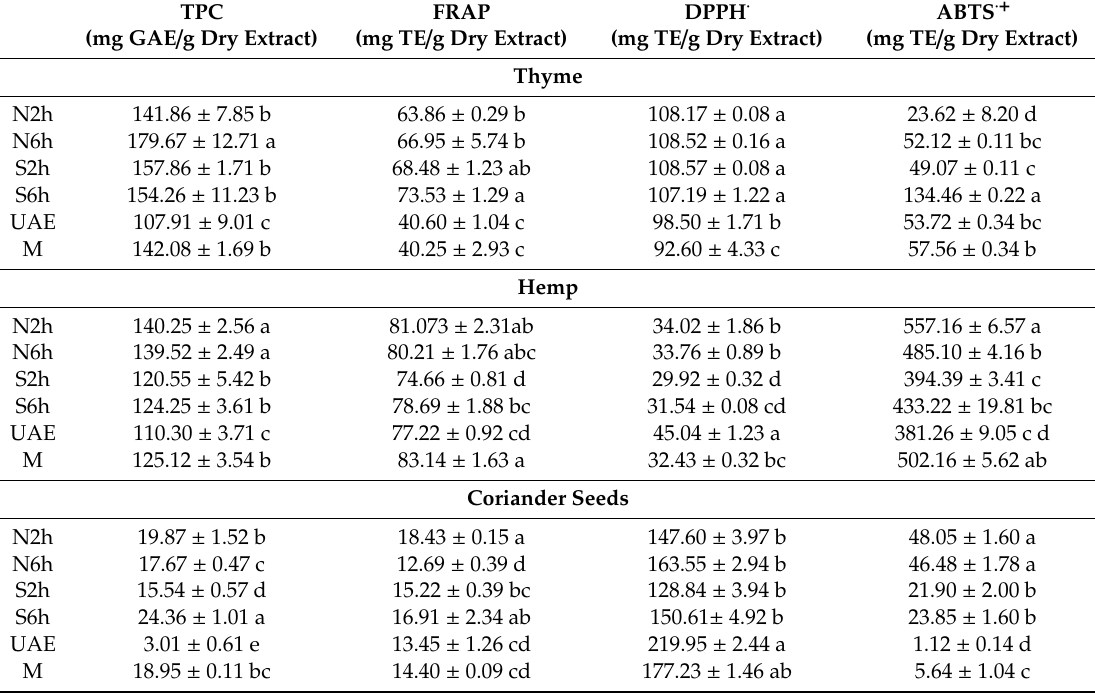
Table 4. Total phenolic content (TPC) and antioxidant activity. Ferric Reducing Antioxidant Power (FRAP), and Trolox Equivalent Antioxidant Capacity with 2,2-diphenyl-1-picrylhydrazyl (DPPH˙), and 2,2 (cid:48) -azinobis-(3-ethylbenzothiazoline-6-sulfonic acid (ABTS˙ + ) of extracts of di ff erent